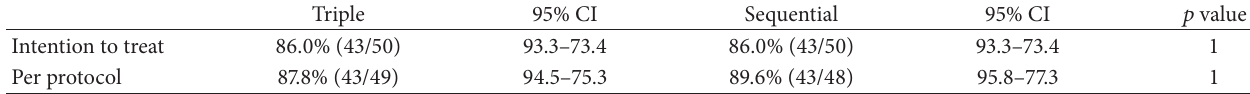
Table 2: Helicobacter pylori eradication rates with triple and sequential therapy.